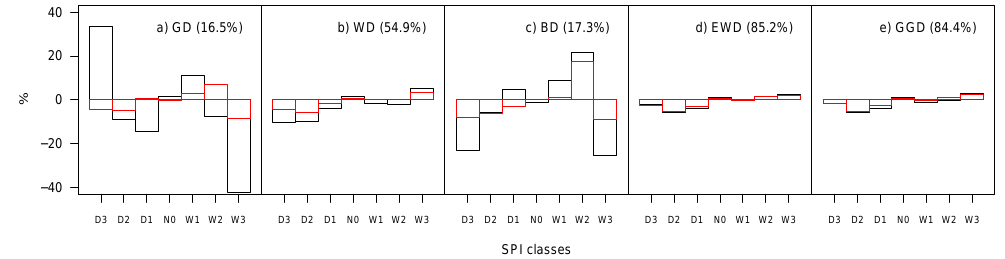
Fig. 11. Differences to the expected probabilities of the SPI classes in percent (ECHAM5 data set), using all grid points of the European region (black). SPI time series are calculated with (a) GD, (b) WD, (c) BD, (d) EWD and (e) GGD. The percentages each distribution is approaching AICD ≤ 2 is given in parentheses. Additionally, the differences for SPI time series selected according to this criterion are given (red).